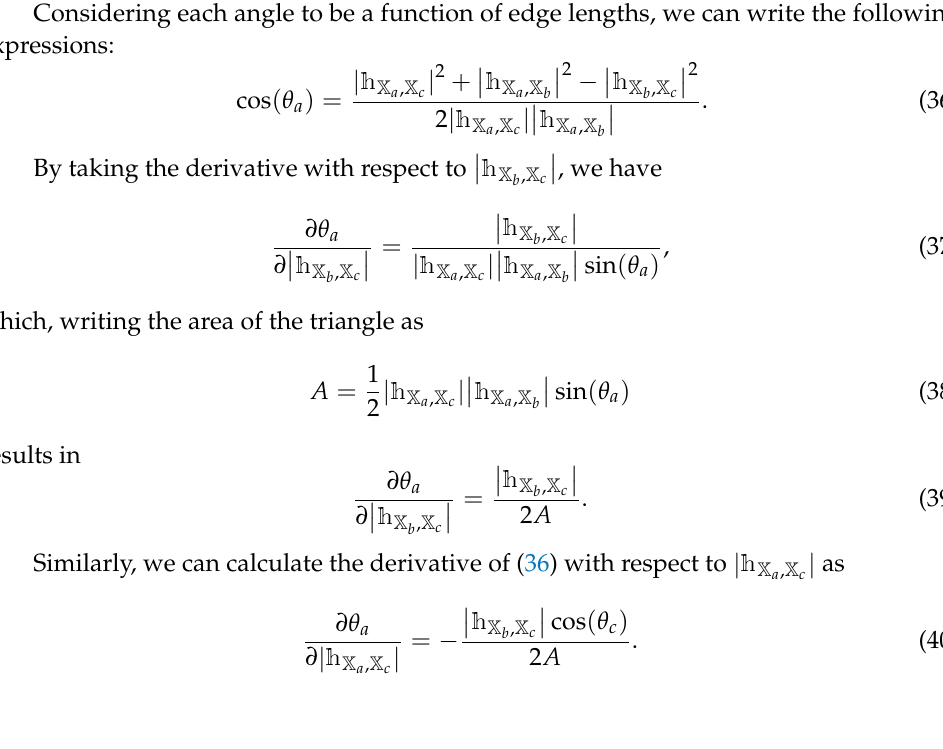
Figure 8. Two-dimensional triangle formed from points with nodal positions X a , X b and X c